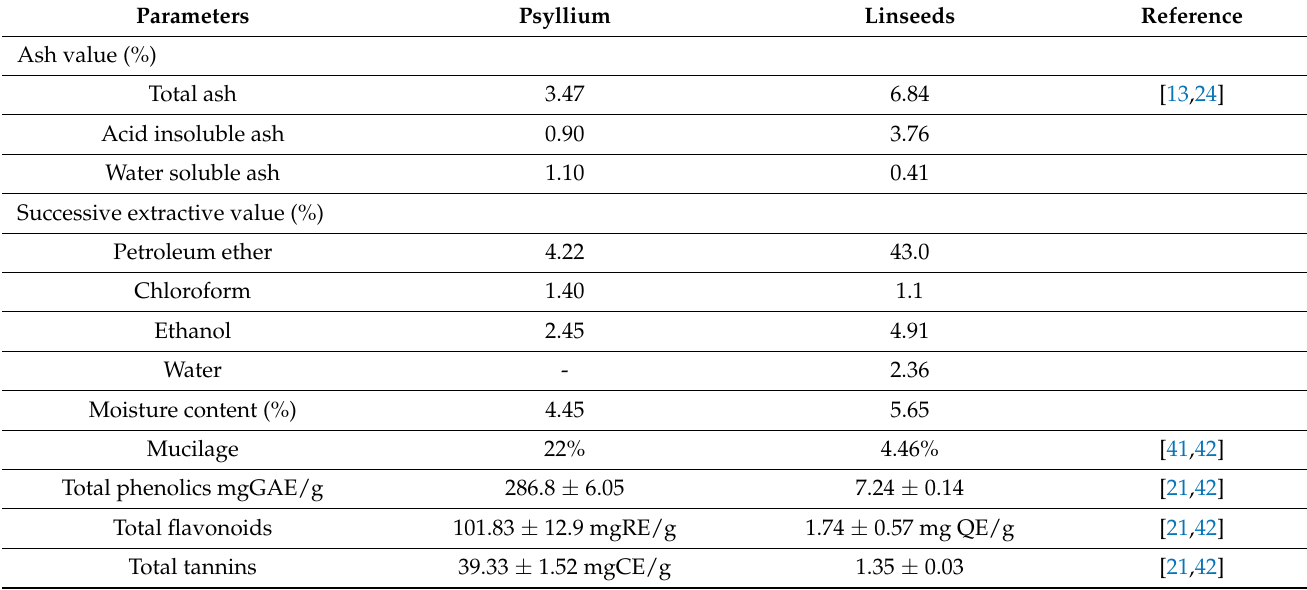
Table 2. Physicochemical parameters of whole seeds of psyllium and